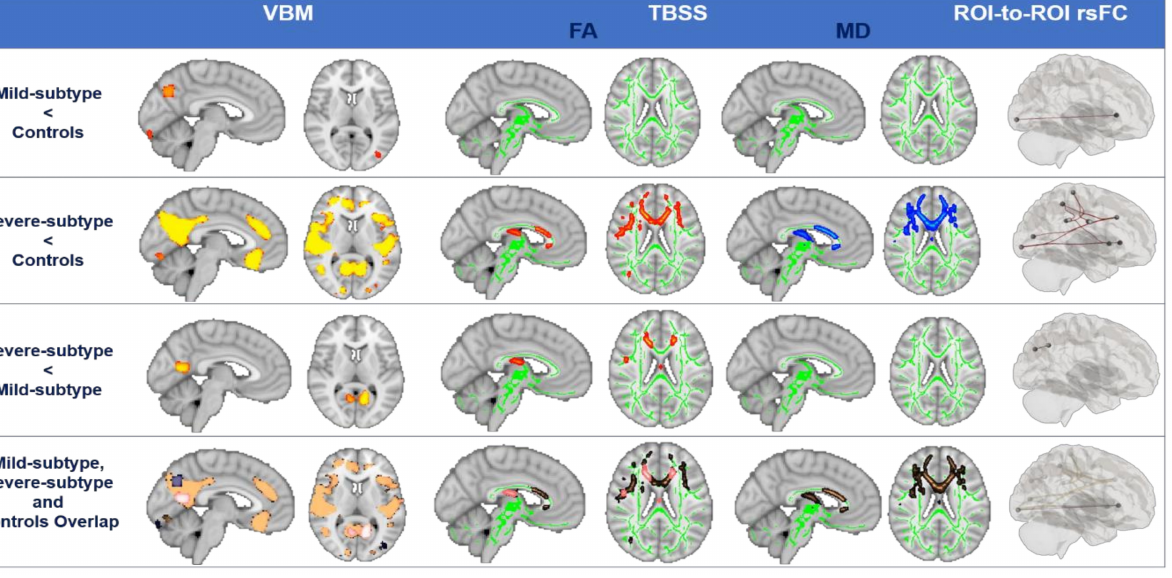
Figure 4. Structural and functional brain degeneration in synucleinopathies compared to controls. Voxel-based morphometry (VBM), tract-based spatial statistics (TBSS), and region of interest